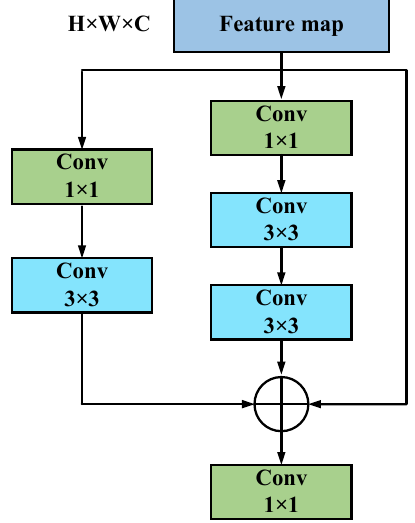
Figure 7. Schematic diagram of attention residual block.